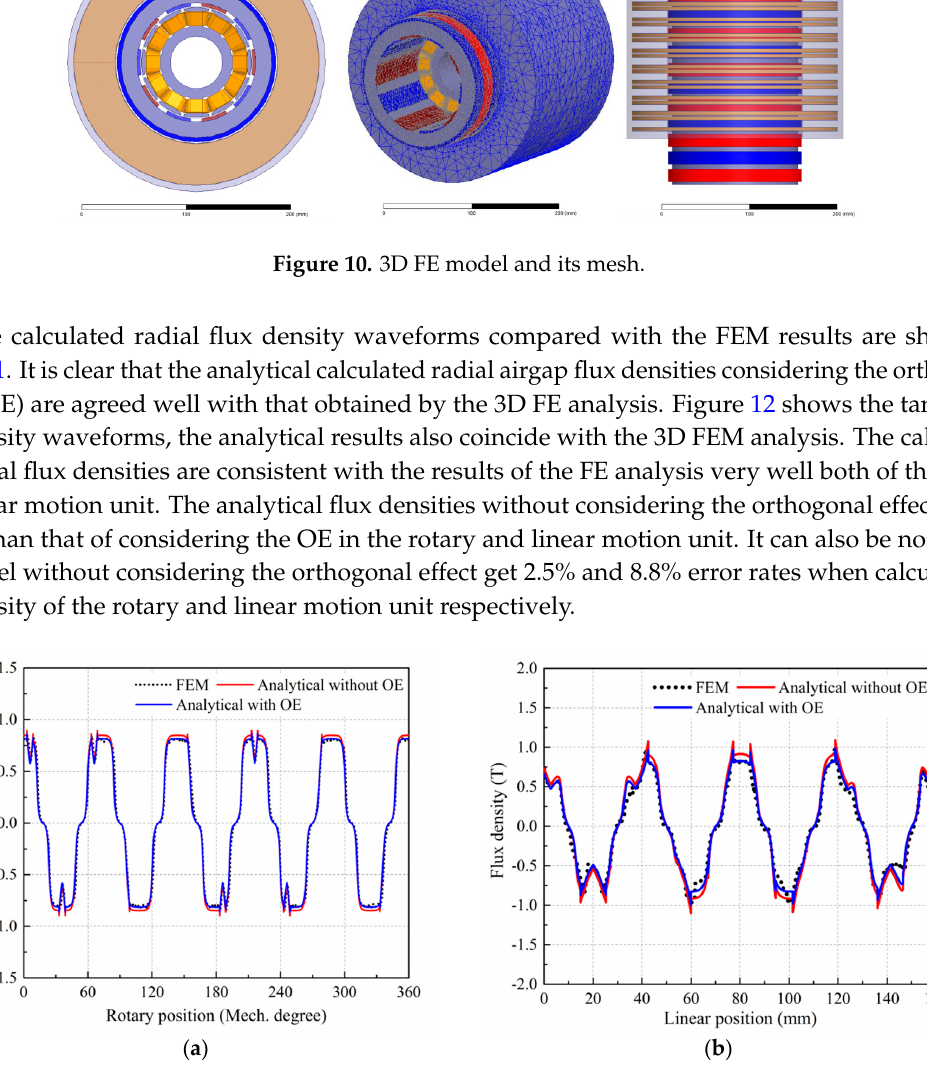
Figure 11. Radial flux density of the DSLRPMM. ( a ) Rotary motion unit; and ( b ) linear motion unit.